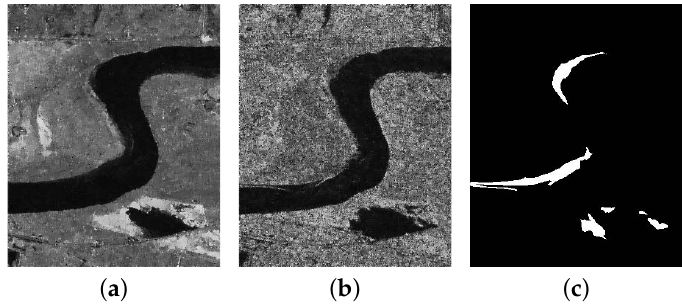
Figure 11. Multitemporal images relating to the inland water of the Yellow River Estuary and the reference image. ( a ) Image acquired in June 2008. ( b ) Image acquired in June 2009. ( c ) The reference image.